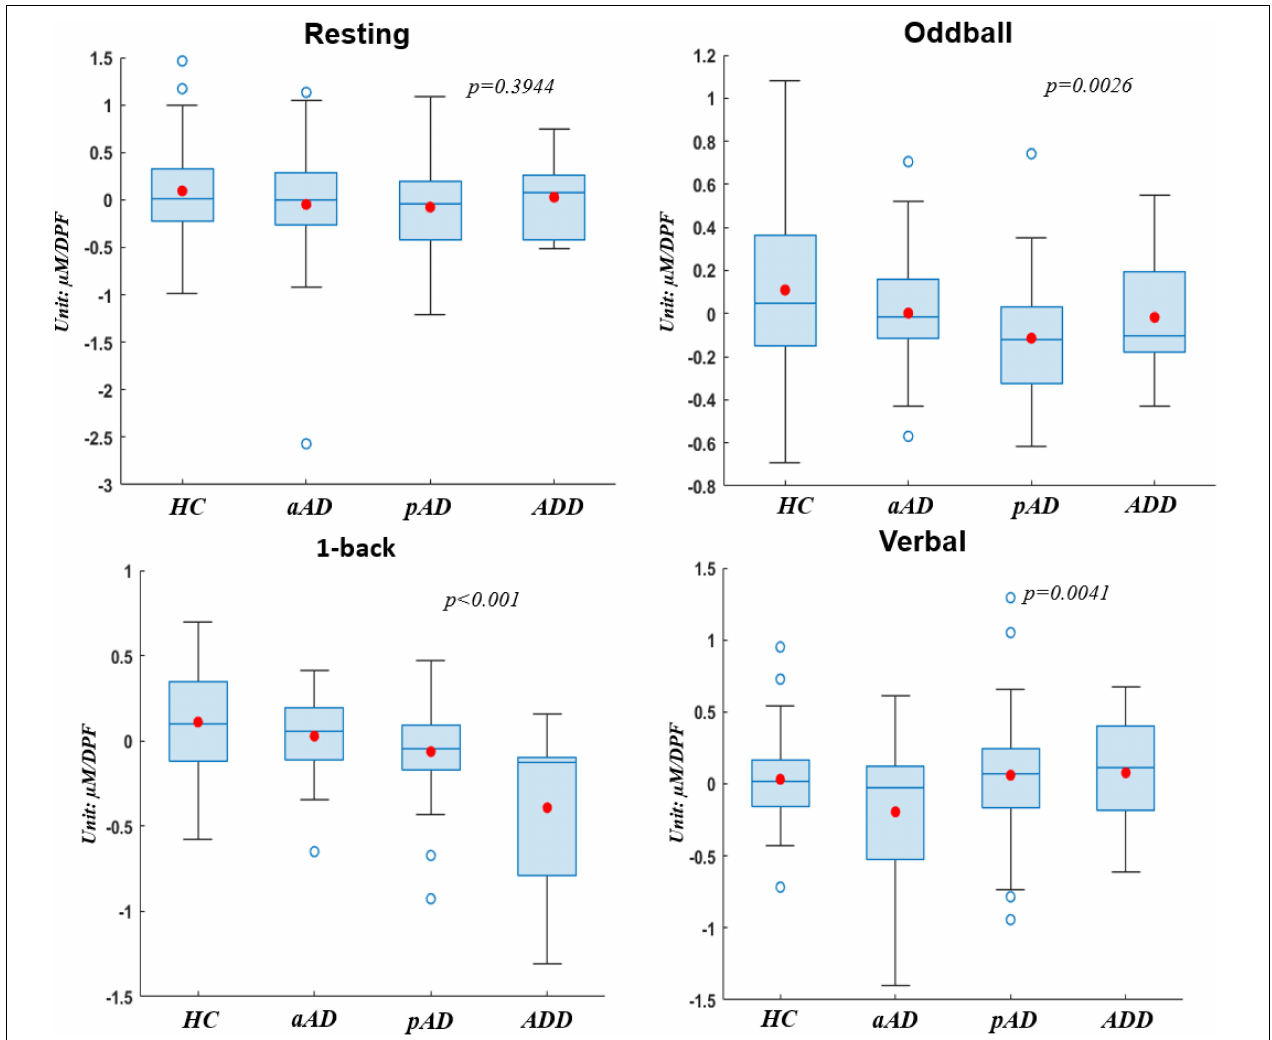
FIGURE 4 | Box charts of oxyhemoglobin (HbO) concentrations acquired by four subject groups under four conditions.